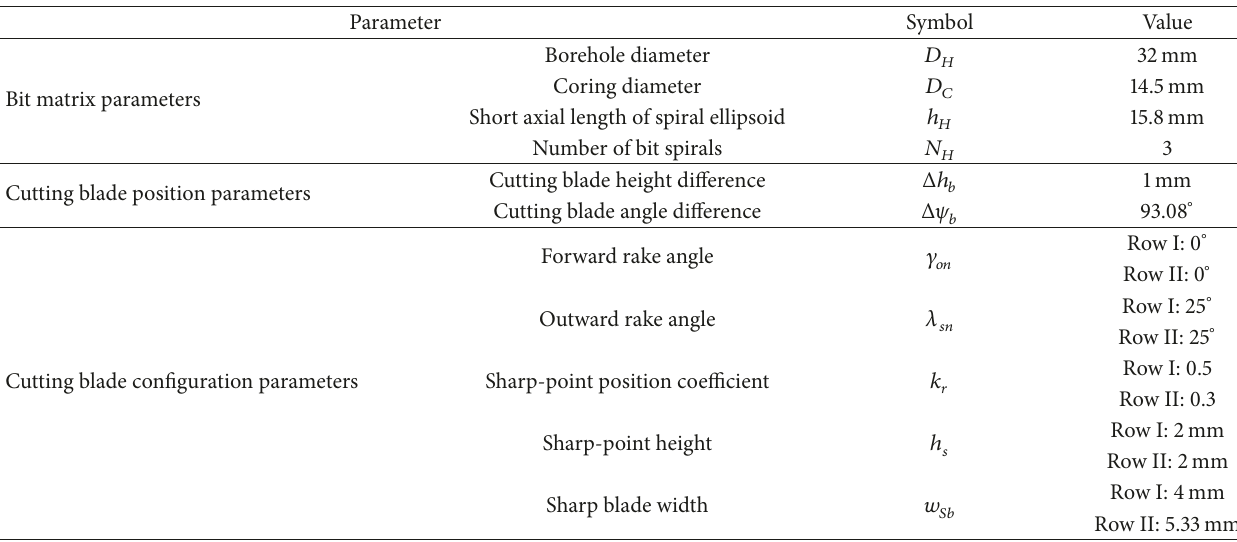
Table 1: LRCB configuration